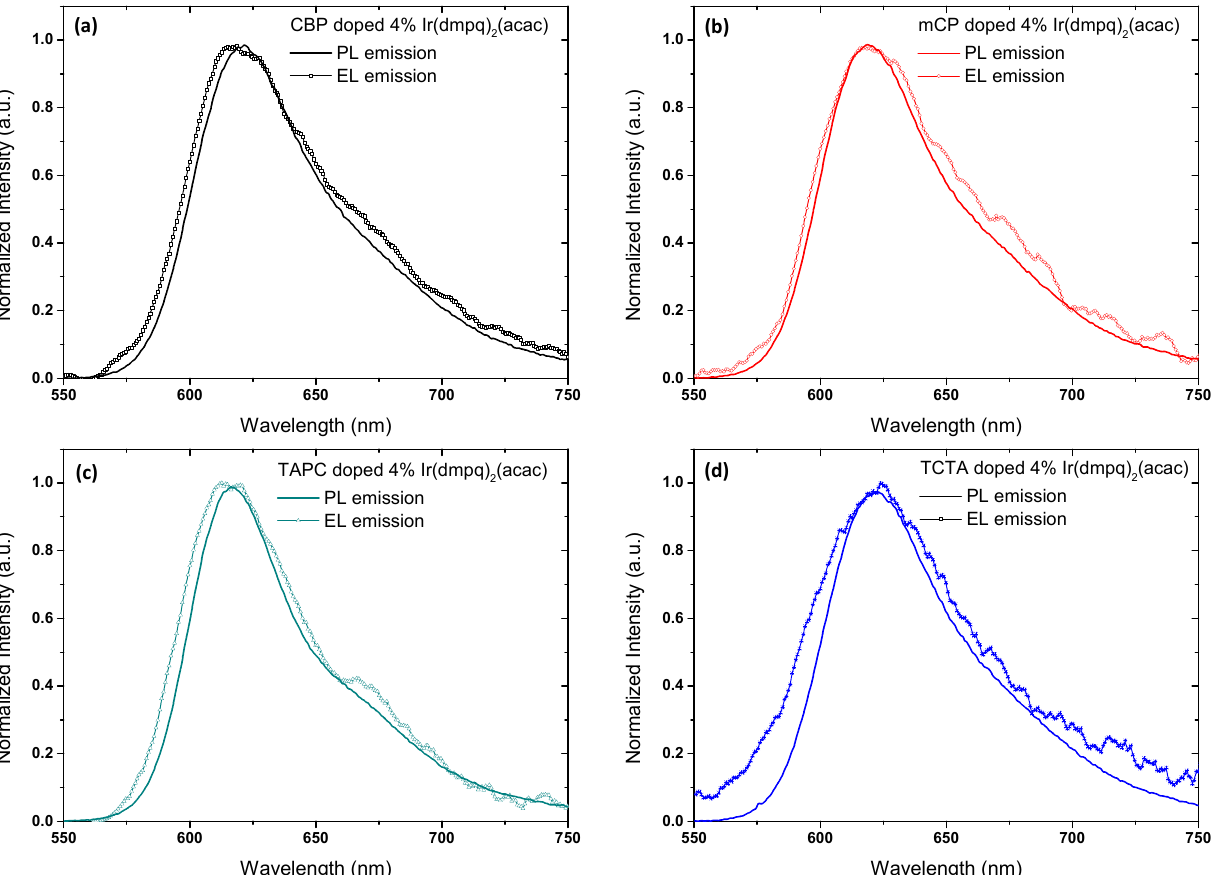
Figure 5. The normalized EL spectra of the PhOLED devices of the Ir-complex doped in: ( a ) CBP; ( b ) mCP; ( c ) TAPC; ( d ) TCTA as well as the respective PL spectra for comparison.